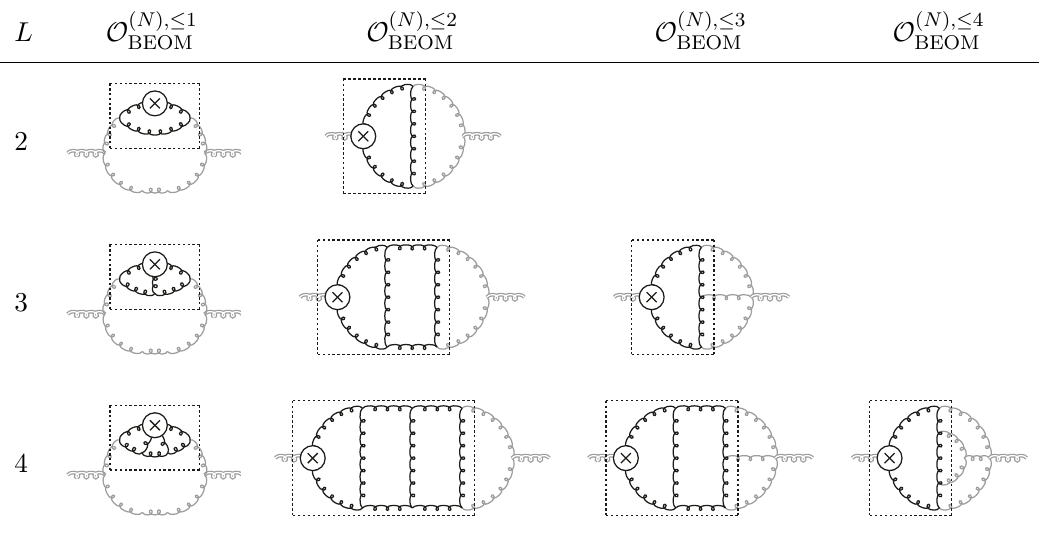
Table 4 . In the L th row the table gives examples of diagrams contributing to the L -loop contri- bution to Γ ( N ) . Subgraphs whose UV-counterterms require the various EOM operators O ( N ) ,k O 1 ; BB are highlighted with dashed boxes.